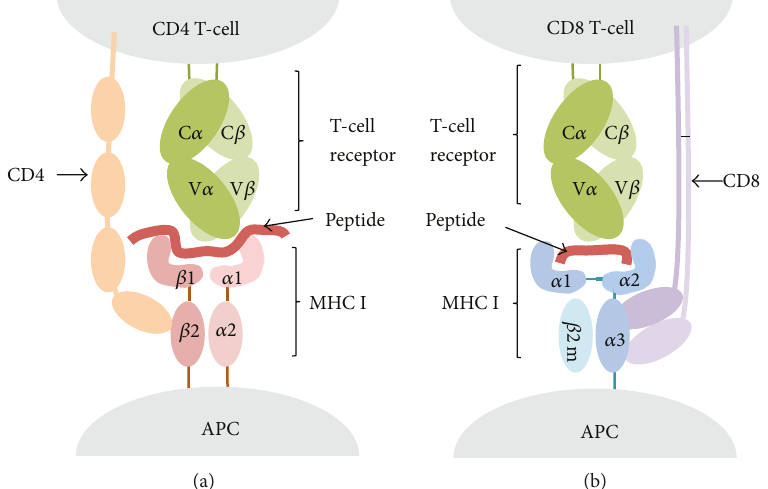
Figure 2: T-cell epitope recognition. T-cell epitopes are peptides derived from antigens and recognized by the T-cell receptor (TCR) when bound to MHC molecules displayed on the cell surface of APCs. (a) CD4 T-cells express the CD4 coreceptor, which binds to MHC II, and recognize peptides presented by MHC II molecules. (b) CD8 T-cells express the CD8 coreceptor, which binds to MHC I, and recognize peptides presented by MHC I